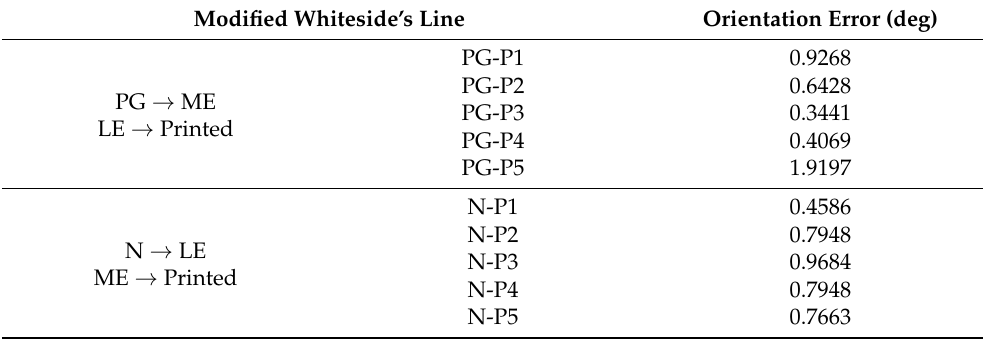
Table 4. The modified Whiteside’s line experiment.